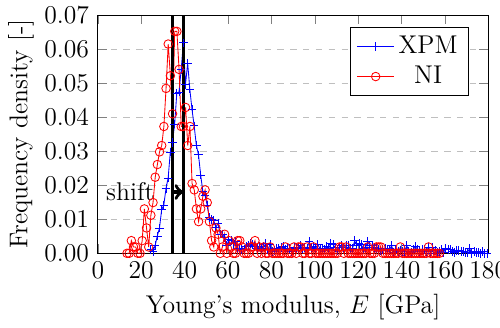
Figure 3. Frequency plots of NI and XPM with highlighted shift of the main peak.